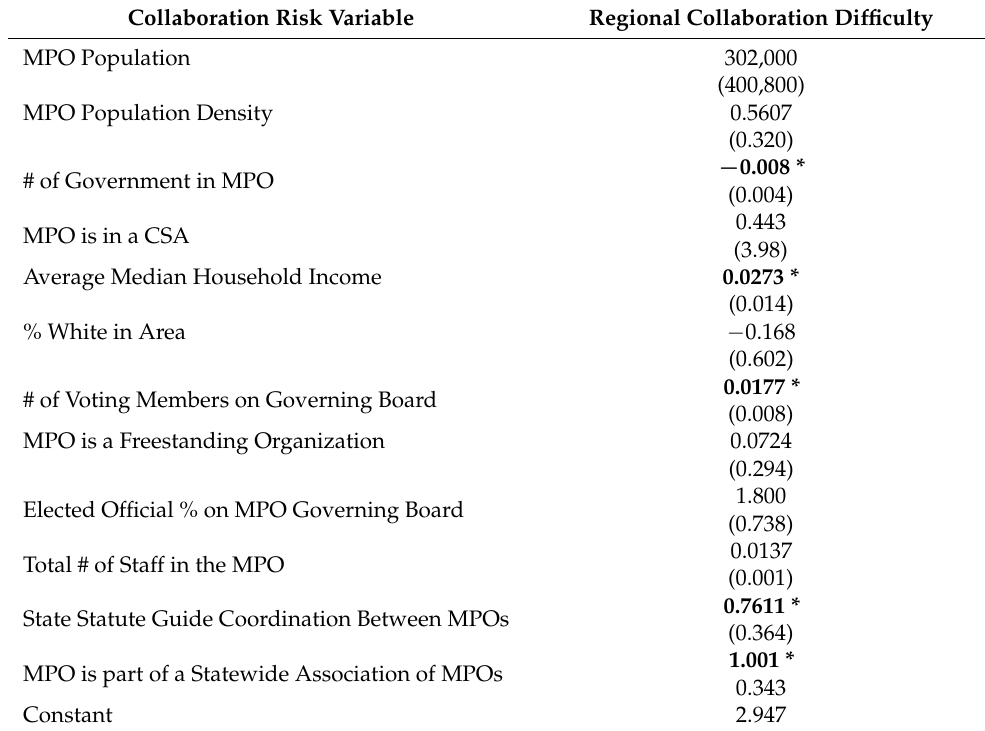
Table 4. Regression for regional collaboration action